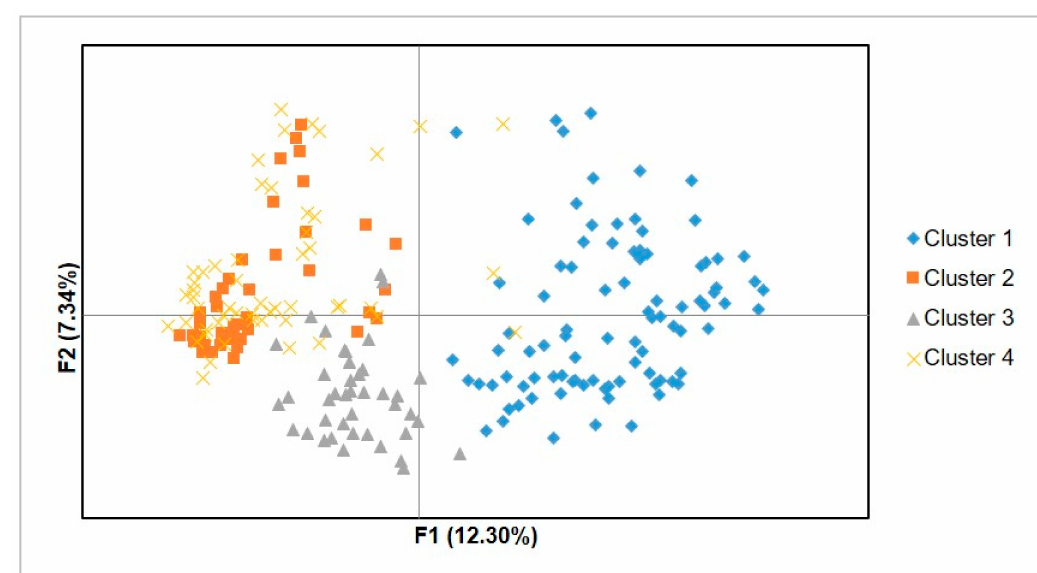
Figure 6. Principal coordinate analysis (PCoA) demonstrating the genetic relationships among individuals of the four clusters identified through DAPC.